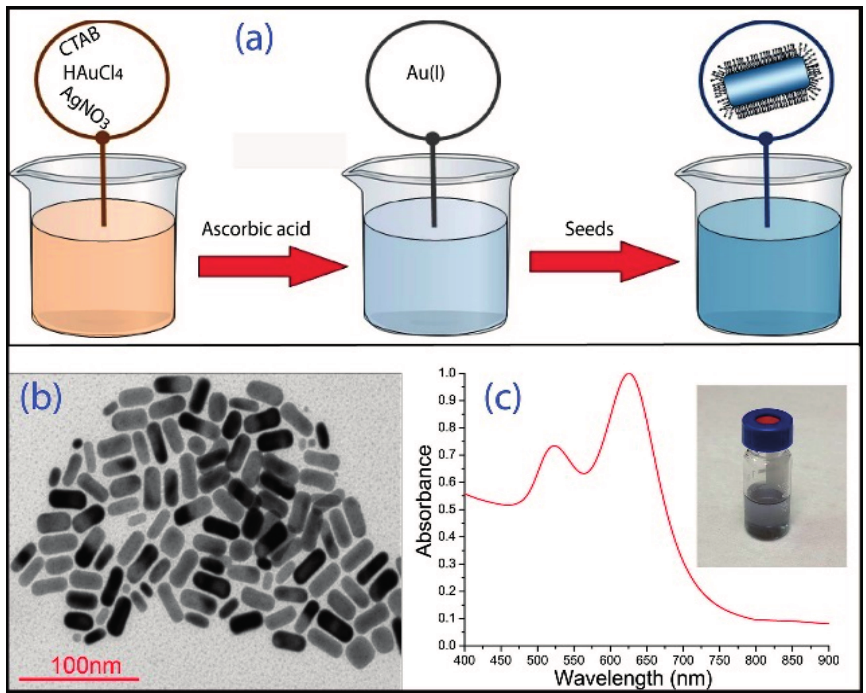
Figure 1. ( a ) Schematization of the synthesis process of gold nanorods (GNRs); ( b ) Transmission electron microscopy (TEM) image of GNRs; and ( c ) Normalized UV-Vis absorption spectrum of an aqueous GNR dispersion (in the inset the picture of a vial containing the same GNR dispersion).